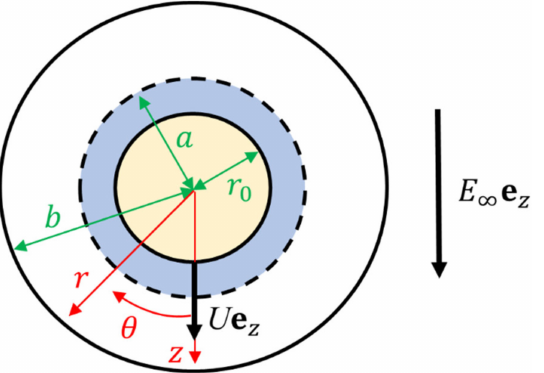
Figure 1. Geometrical sketch for the electrophoresis of a soft sphere in a unit cell for a suspension. To obtain the electrophoretic mobility of the soft particles and effective electric con- ductivity of the salt-free suspension, we first need to determine the distributions of the electrostatic potential, fluid velocity, and counterionic electrochemical potential energy in a unit